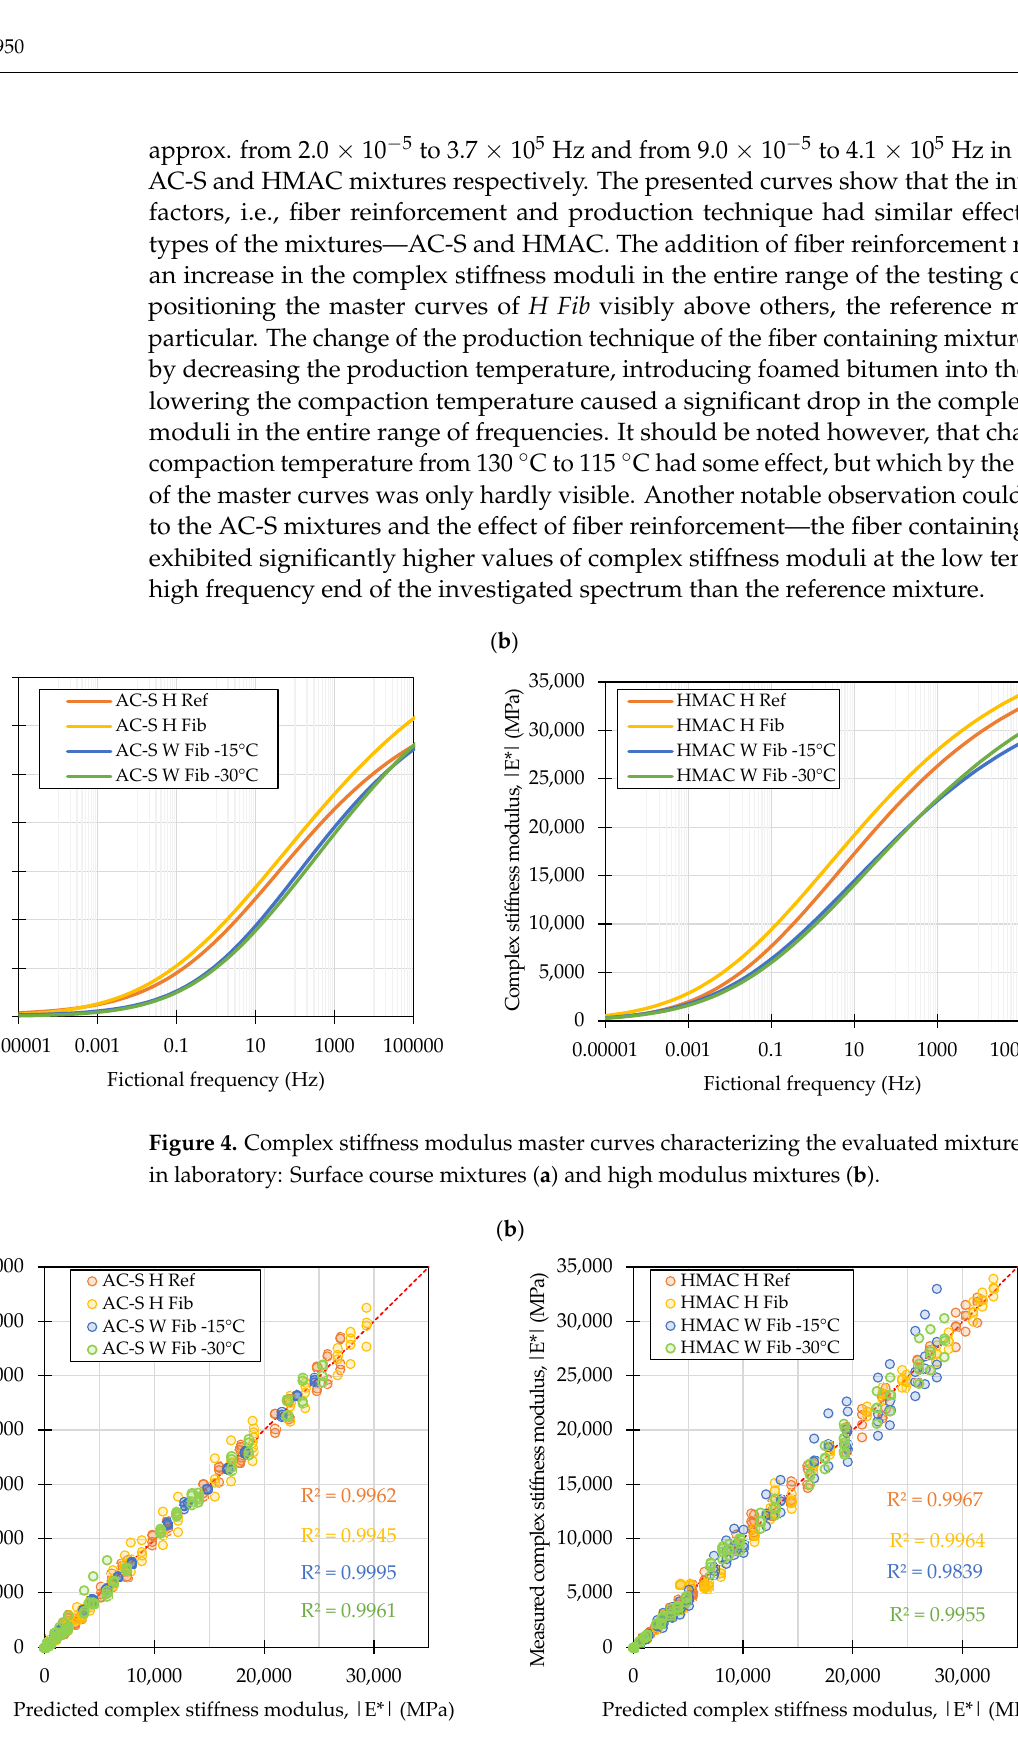
Figure 5. Measured versus predicted values of complex stiffness moduli in samples from laboratory produced mixtures: Surface course mixtures ( a ), high modulus asphalt concrete mixtures ( b ).